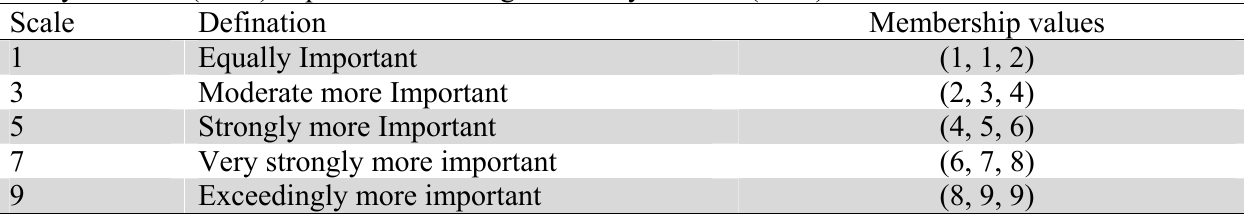
Saaty’s Scales (1 – 9) expressed as Triangular Fuzzy